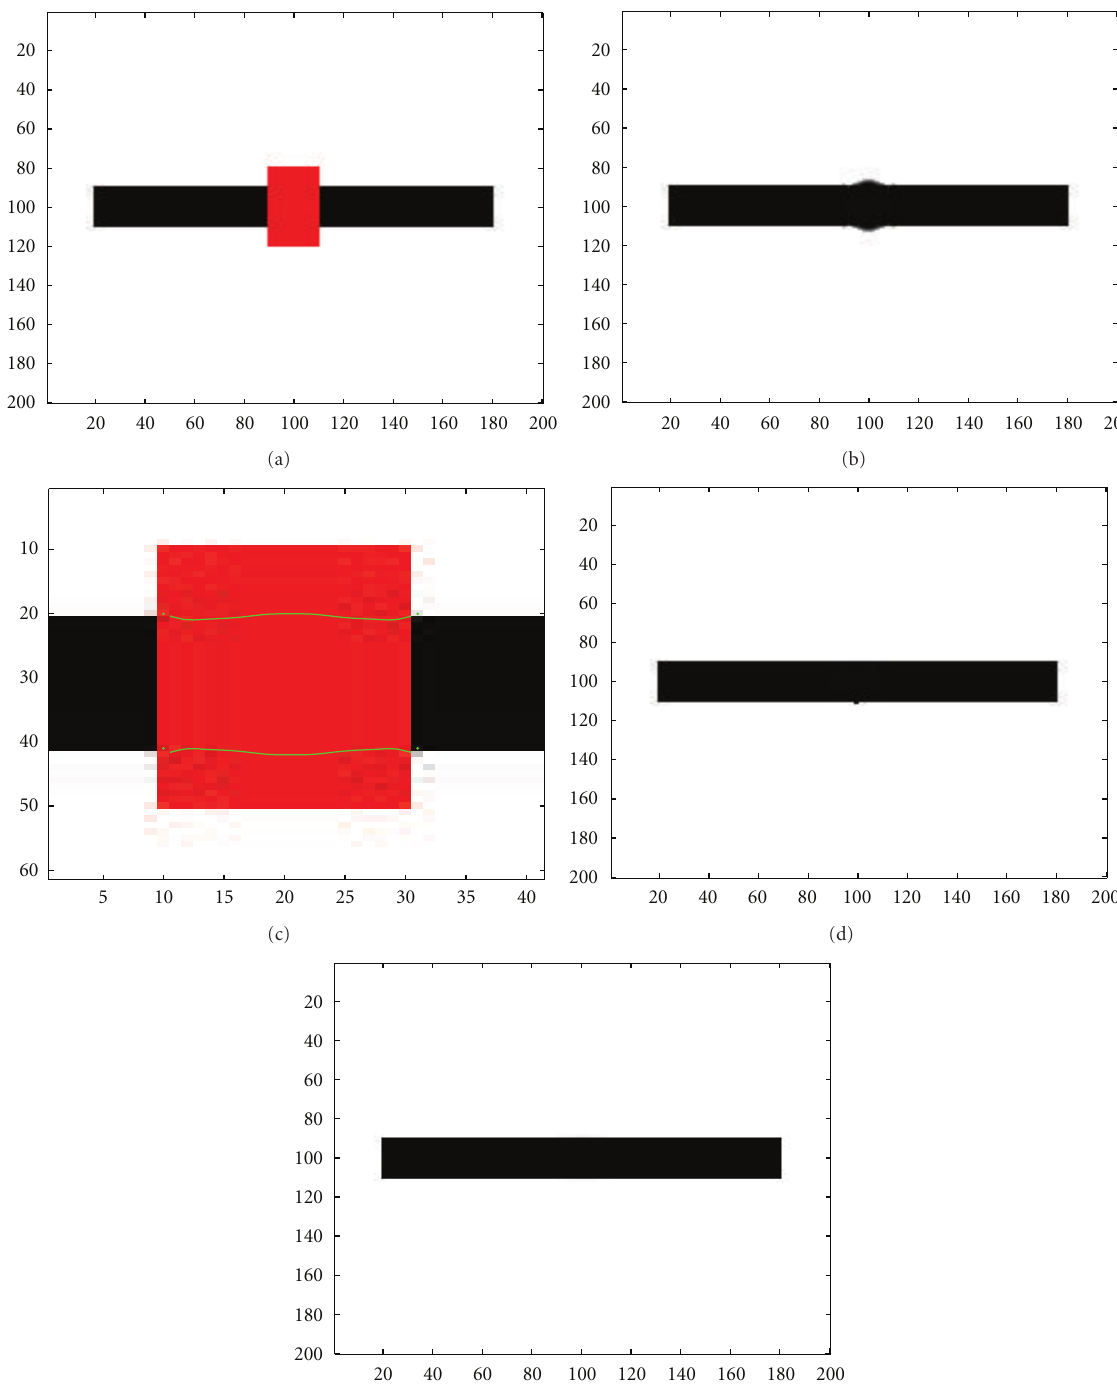
Figure 8: (a) Occluded image (black rectangle) by a red rectangle; (b) Inpainted image using the standard topological gradient; (c) Minimal path between the keypoints represented on the topological gradient; (d) Inpainted image using the hybrid scheme (fast marching algorithm for closing the contours identified by the topological gradient); (e) Inpainted image using a TV-based method. unsatisfactory results, due to badly connected edges. Even if now connects wrong keypoints, and the inpainted image the topological gradient has strongly negative values along by the hybrid scheme is no more connected. As before, the the missing edges close to the boundary of the perturbation, TV-based method does not connect the two parts of the the missing zone is too wide, and the minimal path technique